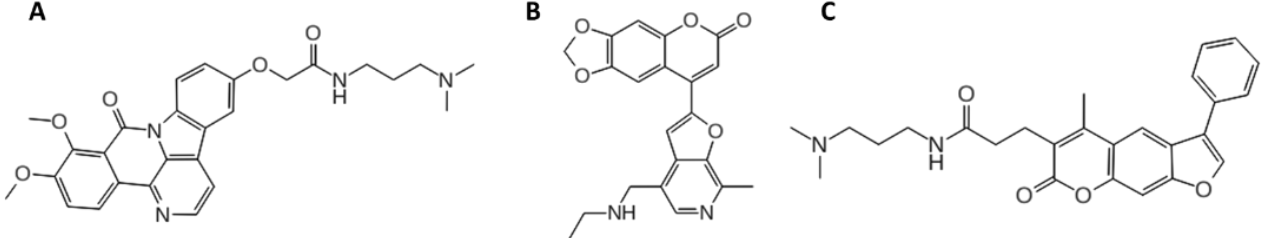
Figure 1. The 2D chemical structures of the three best hits found in our previous VS campaign on bimolecular Tel 2 /TERRA 2 G4s: ( A ) hit 7 , characterized by a naphthyridine scaffold with a ((dimethylamino)propyl)acetamide side chain; ( B ) hit 15 , exhibiting a furo-chromene structure; and ( C ) hit 17 , distinguished by a benzofuran ring [35].